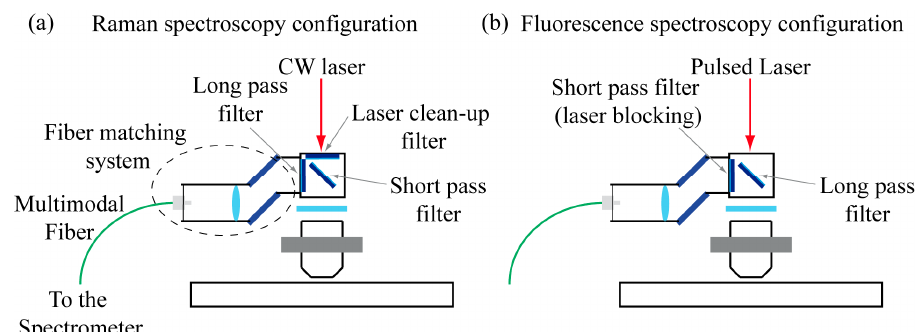
Figure 3. ( a ) The setup configuration used for Raman spectroscopy acquisitions, the signal is backward collected, separated from the excitation laser by a dichroic, coupled to an optical fiber and then delivered to the spectrograph. ( b ) The two-photon fluorescence spectroscopy configuration; in this case the laser light has longer wavelength and the filters have to be switched.